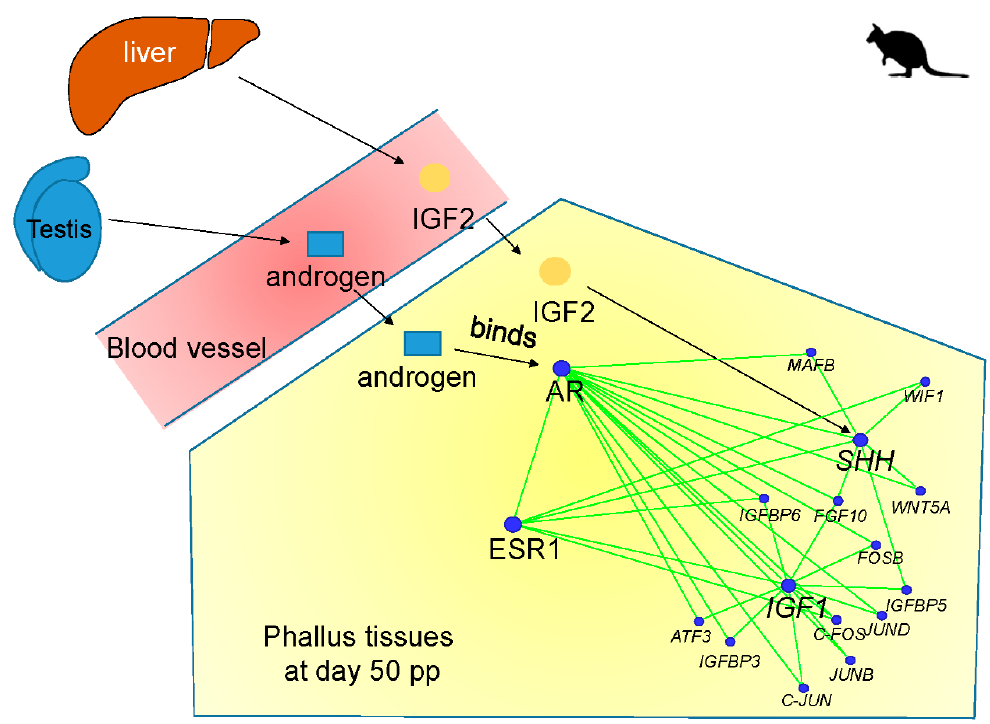
Figure 6. Summary of IGF2-SHH and androgen-IGF1 signalling networks. The activation of IGF2-SHH and androgen-IGF1 signalling networks initiate urethral closure in males, whereas in females, non-activation of those two signalling networks results in an unfused urethra.